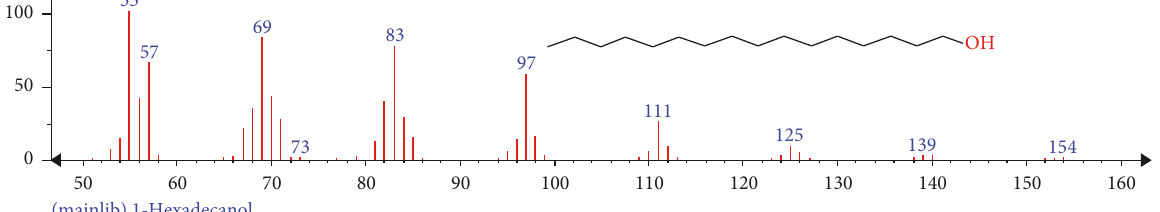
Figure 38: Mass spectrum of compound 1-hexadecanol of whole plant hexane fraction of Achillea wilhelmsii (WHFAW).